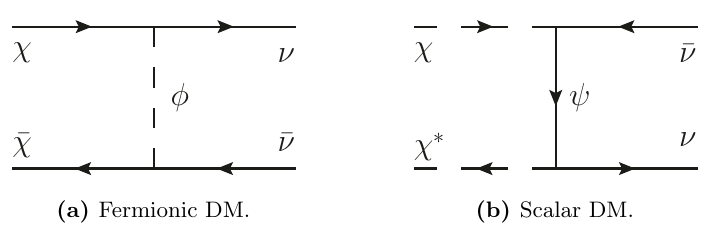
Figure 1. The DM self annihilation diagram for the case of fermionic DM and scalar DM. observed on Earth can be written as